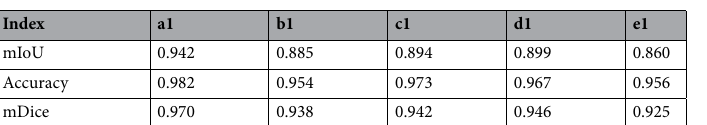
Table 3. The mIoU, Accuracy and mDice with our CES method on carbon steel images 8 , and titanium alloy ( TiAl ) images in Fig. 6. a1, b1, c1, d1, e1 are corresponding with same indices in Fig.